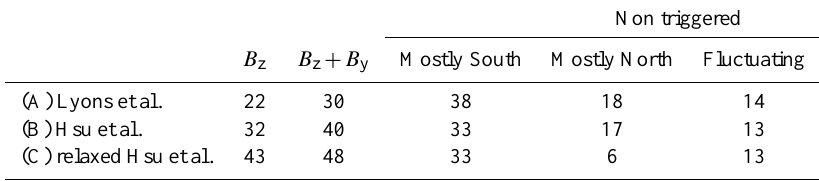
Table 2. Same as Table 1 but for the event list from IMAGE-FUV.